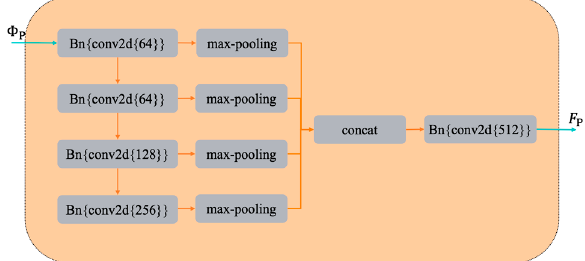
Figure 17. Point feature extractor of DeepMerge.